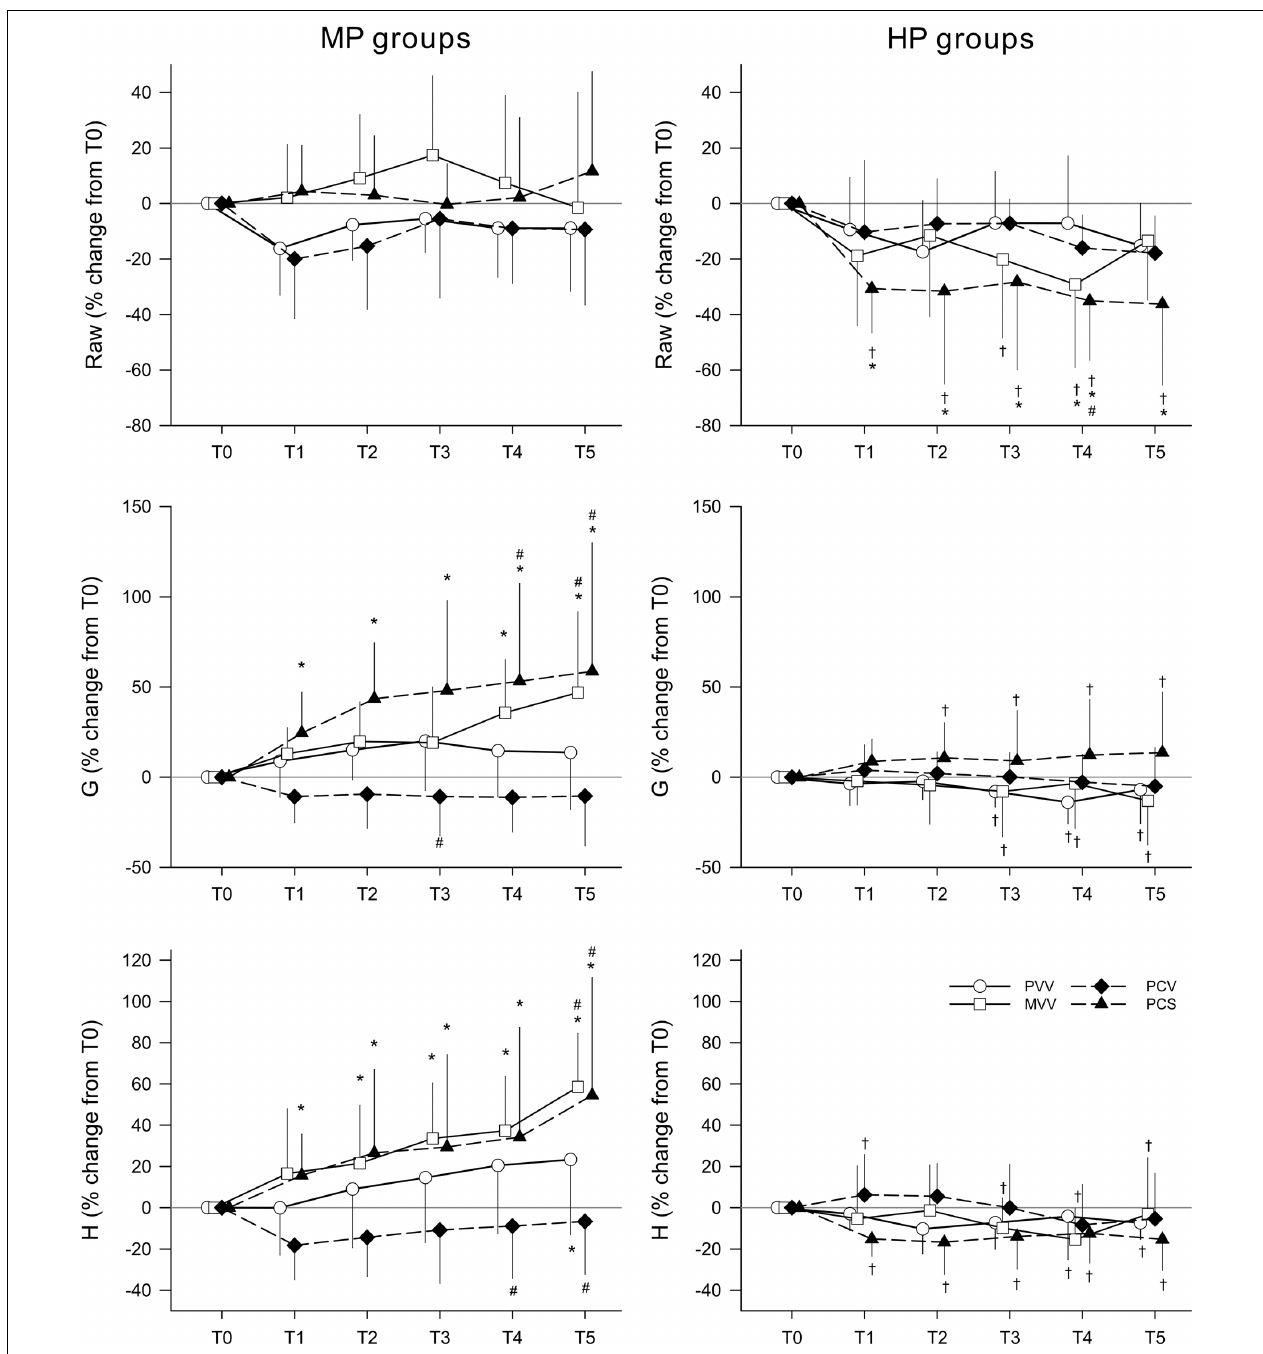
FIGURE 2 | Changes in respiratory mechanical parameters during the application of various ventilation modes compared to values obtained before application (T0). Left panels display changes in groups ventilated with a PEEP of 6 cmH 2 O, whereas groups depicted in the right panels were ventilated with a PEEP of 9 cmH 2 O. Data are presented as group means ± half-width of 95% confidence interval. Raw, airway resistance; G, tissue damping; H, tissue elastance; T1–T5, measurement points at the end of each 5 h of ventilation with an experimental pattern; MP, moderate PEEP; HP, high PEEP; PVV, physiological variable ventilation; MVV, mathematical variable ventilation; PCV, pressure-controlled ventilation; PCS, pressure-controlled ventilation with regular sighs. Results of the ANOVA analyses ( p -values) for factor “ventilation mode.” p = 0.44 for Raw, p < 0.01 for G and p = 0.02 for H; for factor “PEEP.” p < 0.01 for all variables; for the interaction of “ventilation mode ∗ PEEP p < 0.01 for all variables; for interaction of “ventilation mode ∗ PEEP ∗ time.” p < 0.01 for all variables. ∗ p < 0.05 vs. T0. # p < 0.05 vs. PVV. † p < 0.05 vs. MP.